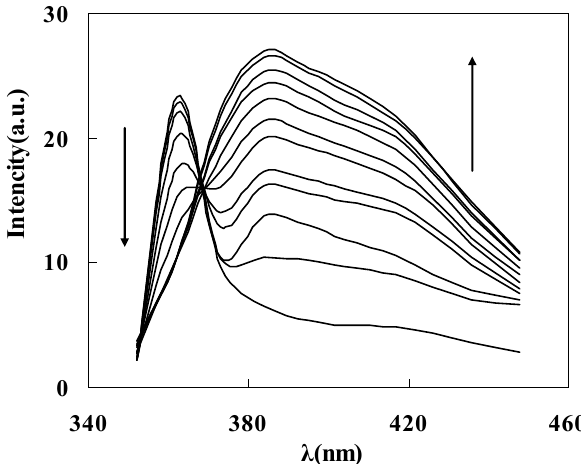
Figure 8. Fluorescence spectra of DAPD-SMN in ethanol at different concentration of Cu 2+ . C DAPD-SMN = 20 mg·L − 1 , C Cu2+ = 0~3 × 10 − 6 mol·L − 1 , λ ex = 334 nm.